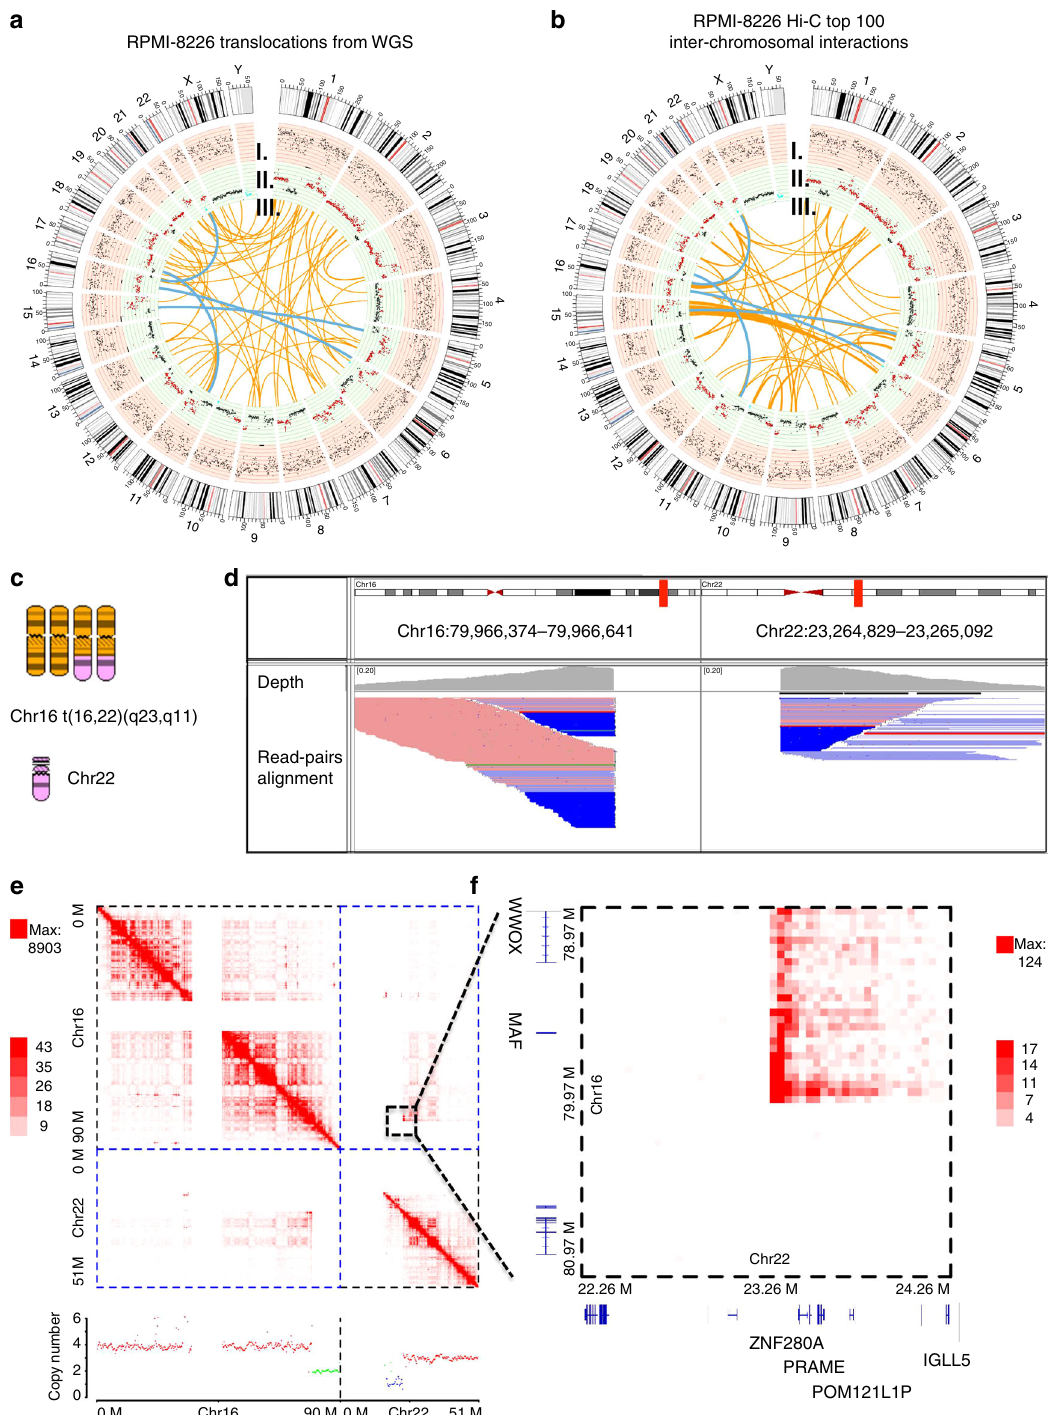
Fig. 2 Hi-C data reveal translocation events. a Fifty-six inter-chromosomal translocation events identi fi ed in RPMI-8226 by WGS. From outer circle to inner circle: panel I: average RNA-seq count for every 200 kb chromosome bin; panel II: CNV data from WGS (black dots: copy number equal to 2, red dots: copy numbers larger than 2, green dots: copy numbers less than 2); panel III: orange lines: translocation events, blue lines: translocation events that are among the top 100 highest inter-chromosomal Hi-C interactions in b . b The 100 highest inter-chromosomal Hi-C interactions in RPMI-8226 cells (5 M resolution): from outer circle to inner circle: panel I and II: the same as in a for RNA-seq counts and CNV data; panel III: orange lines: top 100 highest interactions, blue lines: the common events with a . c The chimeric chromosome formed between chr16 and chr22 identi fi ed by spectral karyotyping (SKY). The SKY image of RPMI-8226 is from the NCBI SKY database. d The translocation event of t(16;22)(q23.2;q11.22) in RPMI-8226 cells plotted by IGV tool, showing only WGS paired reads supporting this translocation event. The reads depth and alignment panels are shown. Read alignments are sorted by read location and colored by read strands. e Top panel: the intra and inter-chromosome interaction maps of chromosome 16 and 22 in RPMI-8226. Bottom panel: copy number variations of chromosome 16 and 22. f Enlarged inter-chromosomal interactions corresponding to the translocation